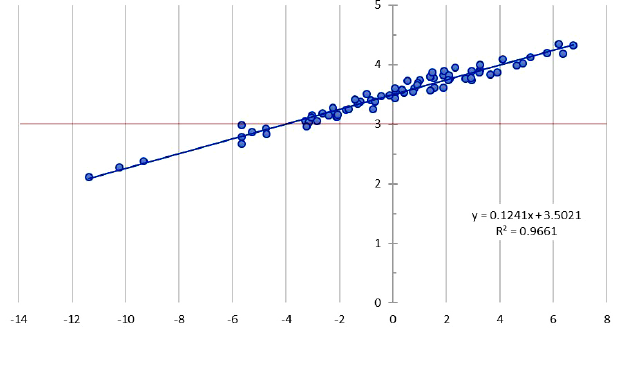
road network (q. 52) as elements of the tourist offer system. Fig. 2 . Principal component 1 (PC1) scores (X axis) vs mean score calculated for each hiking guide (Y axis). The line in red shows the threshold indicating sufficiency (score 3) based on the 1 to 5 scale, which guides used to quantify their response. The figure includes data from all four national parks.